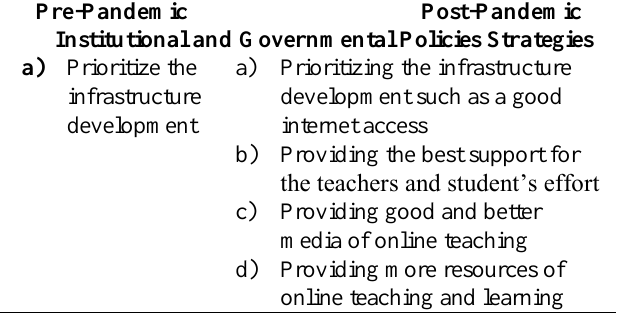
TABLE 13 | Institutional and Governmental Policies Strategy